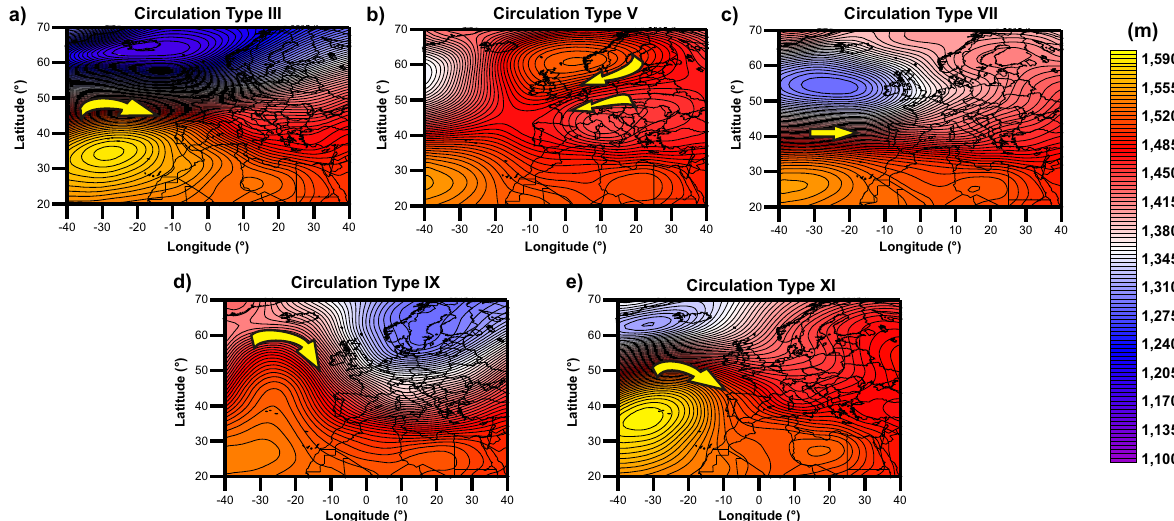
Fig. 6 Synoptic maps describing non-ADO circulation types. Composite synoptic maps of 850 hPa geopotential height at 12 UTC (m) for circulation types (CT-III ( a ), CT-V ( b ), CT-VII ( c ), CT-IX ( d ) and CT-XI ( e )) resulting from the circulation classi fi cation process, which were not associated with the development of ADO, for the period 1948 – 2020. Arrows indicate the prevailing advection of the air masses towards the IP- BI domain.